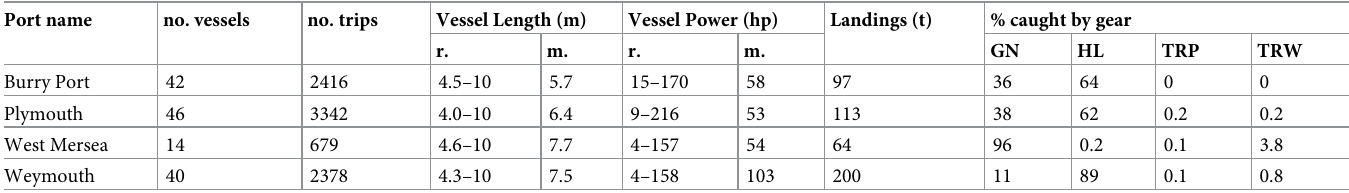
Table 2. Descriptive statistics of chosen vessels from MMO logbook